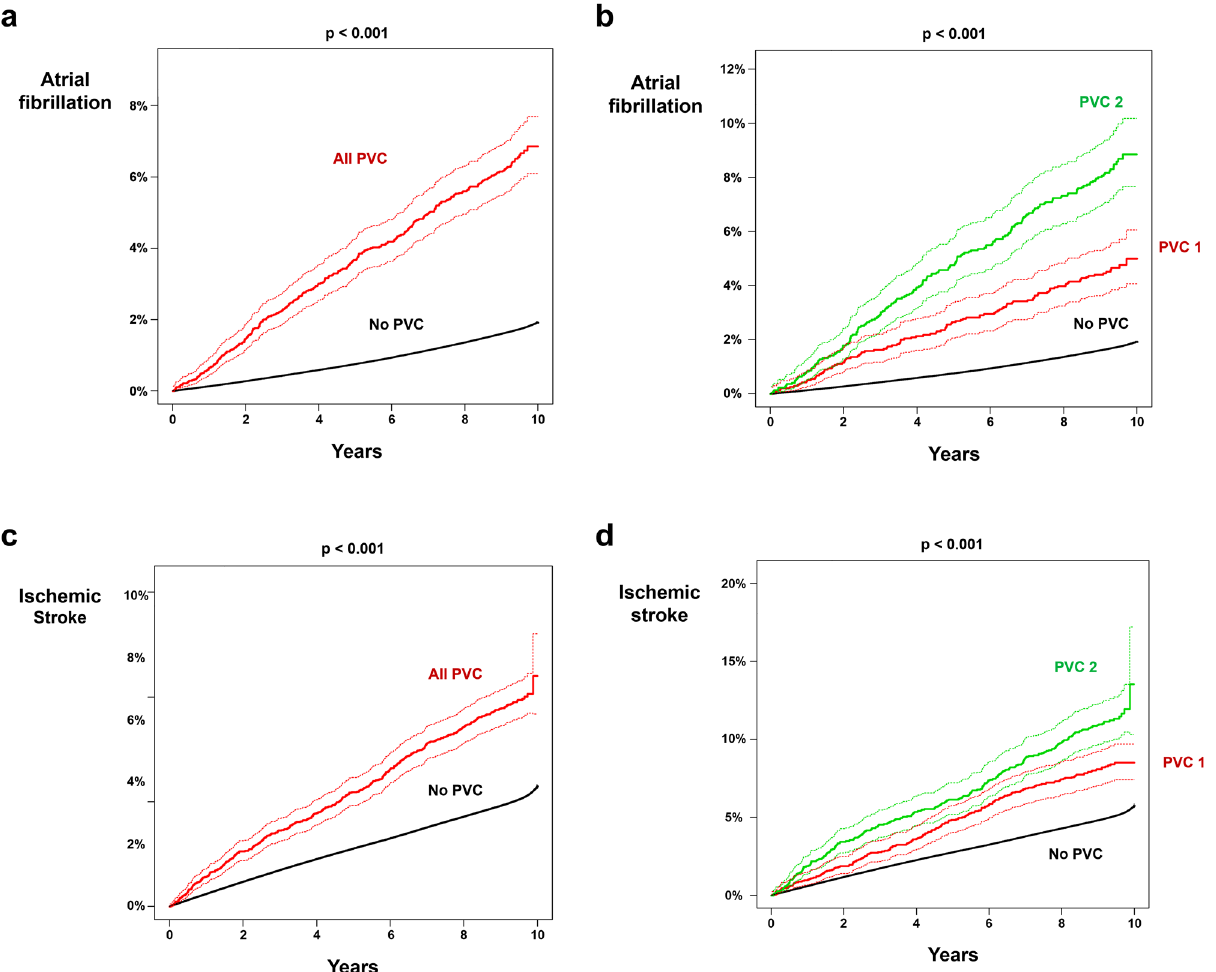
Figure 2. Impact of PVC on new-onset atrial fibrillation and ischemic stroke. Cumulative incidence curve analysis showed a significantly higher incidence of new-onset AF ( a , b ) and ischemic stroke ( c , d ) in people with PVC as compared with people without PVC. Dotted lines represent 95% confidence intervals. PVC premature ventricular